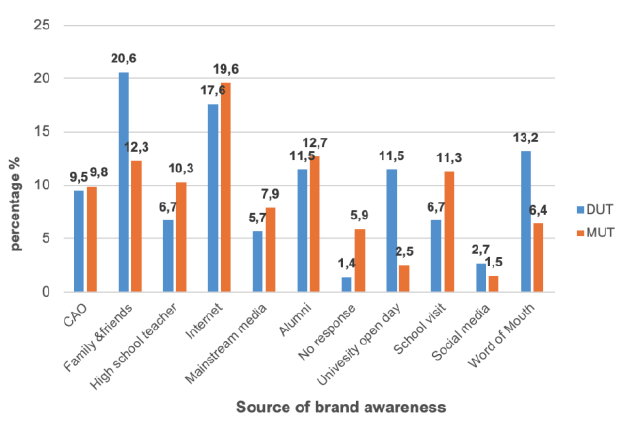
Figure 2: DUT/MUT brand awareness